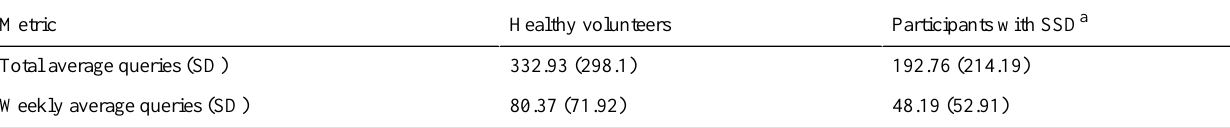
Table 4. Quantity of search data provided per group for the diagnostic